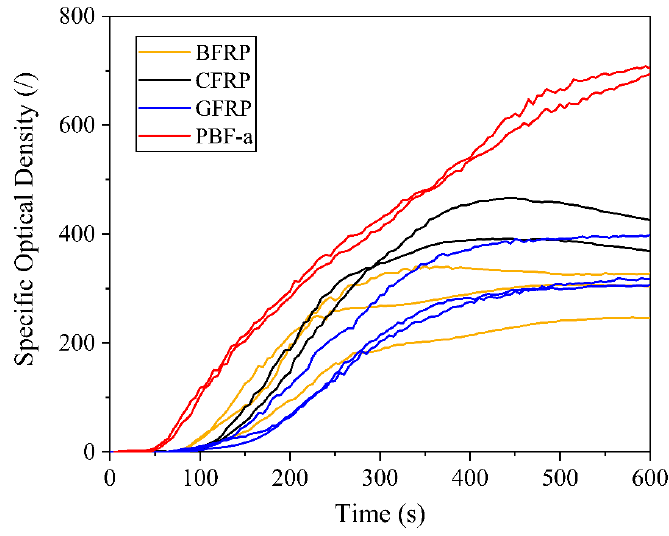
Figure 7. Specific optical density (Ds) as a function of time.